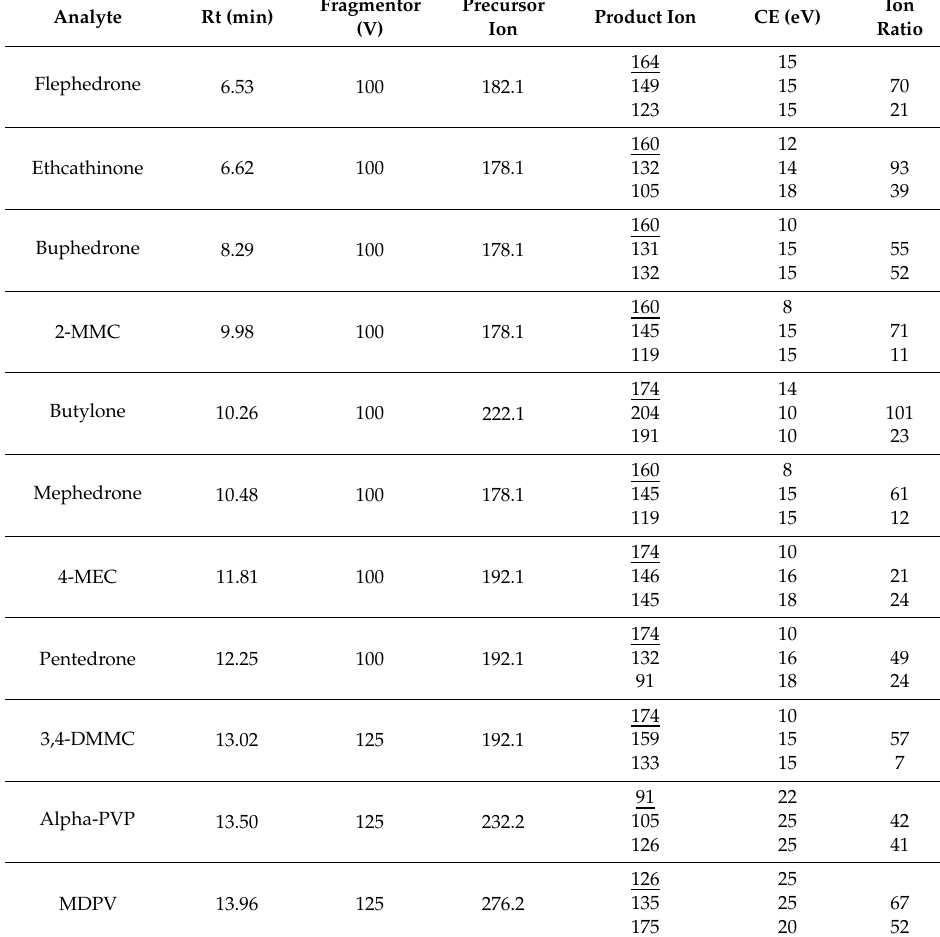
Table 2. Retention time, fragmentor, precursor, product ions (the quantifier ion is underlined), ion ratios, and collision energies of the studied cathinones by LC-MS /